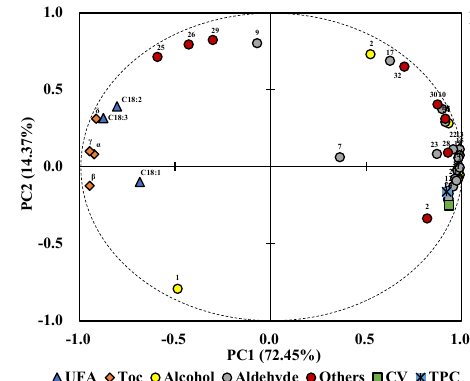
Figure 3. Principal component analysis (PCA) of unsaturated fatty acid (UFA), tocopherol (Toc), volatile compounds, carbonyl value (CV), and total polar compounds (TPC) level in the oil samples with different heating times. ( A ) Score plot; ( B ) Loading plot. The numbering of compounds in ( B ) is the same as the numbering of compounds in Table 4. C18:1, C18:2, and C18:3 represent oleic acid, linoleic acid, and linolenic acid, respectively.